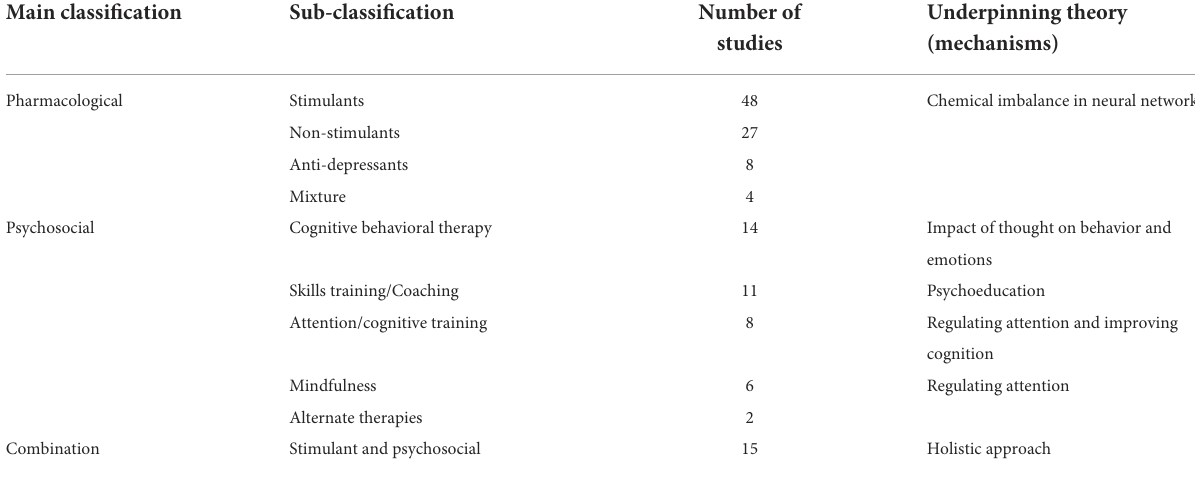
TABLE 4 Study classifications, sub-classifications, and their representative number of studies and underpinning